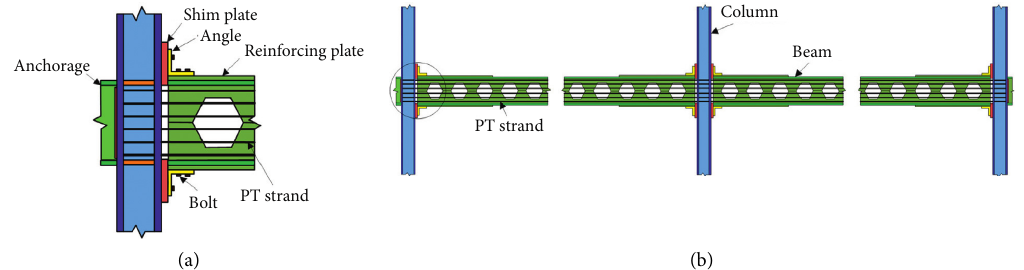
Figure 5: Details of self-centering hexagonal castellated beam connection and frame: (a) PT semirigid beam-to-column steel connection; (b) MRF with PT connections (adapted from [21]).